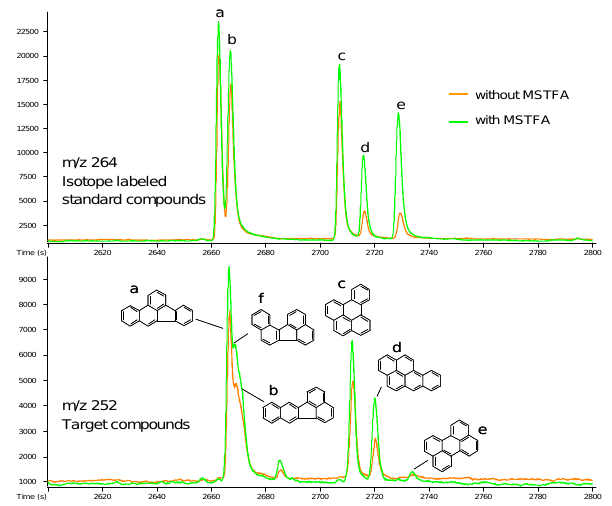
Fig. 3. The effect of filter matrix and MSTFA on sensitivity of PAH analysis. Orange line: 108mm 2 filter of sampled PM 1 (equivalent to 200l aerosol) analysed without MSTFA. Green line: 108mm 2 filter of sampled PM 1 (equivalent to 200 l aerosol) analysed with MSTFA-saturated carrier gas during thermal des- orption.